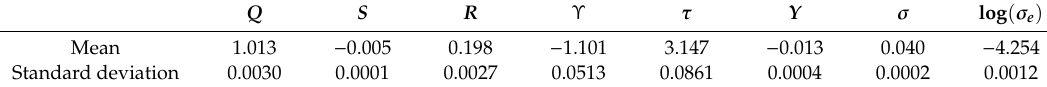
Table 1. Statistics of hyperparameters and error covariance for information level 3.